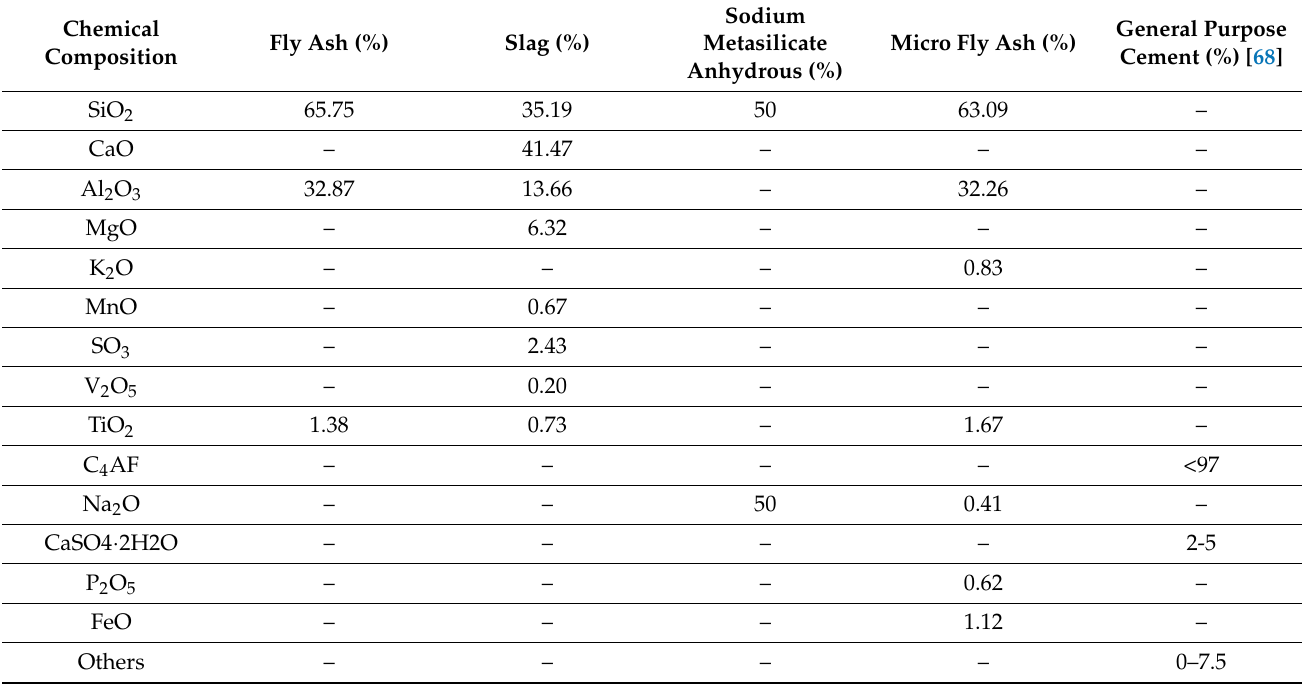
Table 2. The chemical composition of SCGC binder constituents.